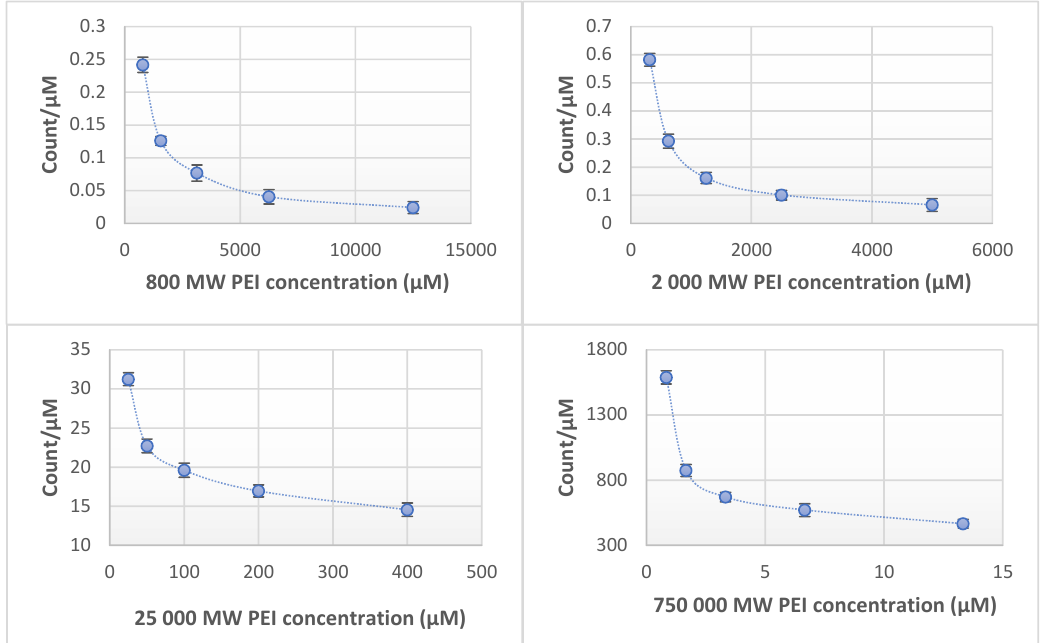
Figure 2. Fluorescent intensity related to molar concentration (count/µM) of PEI with different molecular weights (0.8–2–25–750 kPEI) dilution series. Technical parameters: λ ex = 280 nm; λ em = 290–720 nm; scan speed = 1200 nm/min; PMT voltage = 700 V. Maximal emission: λ em = 560 nm; Ph ≈ 10.6. The standard 3.5 mL quartz cuvette were OD: 12.5 mm × 12.5 mm × 45 mm; wall thickness: 1.25 mm with 10 mm light path and four polished sides. The volume of all the samples was 1 mL. Technical parameters of the assay—sample number: 5 / measuring point; temperature: 23 ◦